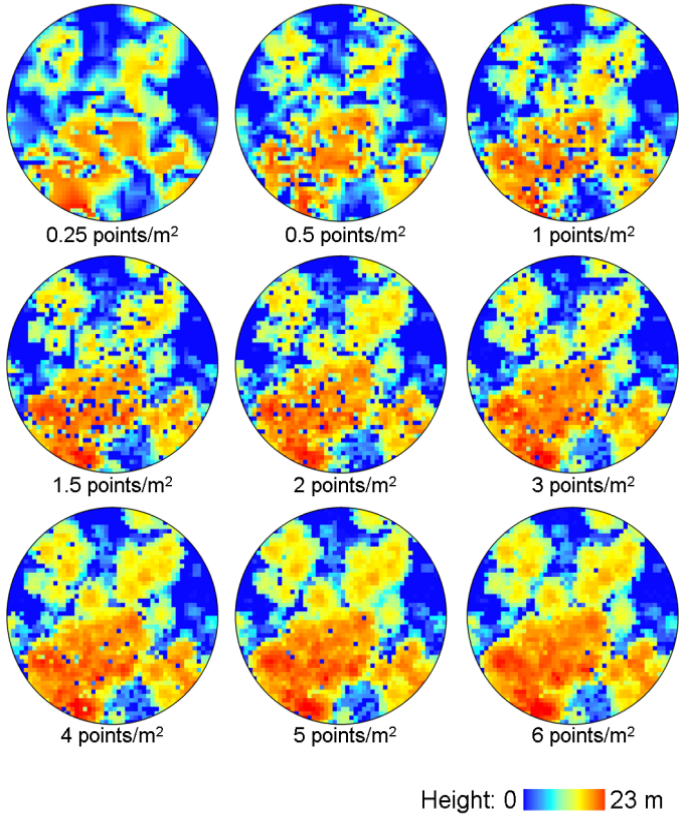
Figure 3. Canopy height models of a sample plot (radius = 25 m) obtained by a progressive variation of the simulated LiDAR density. The grid size of these models is always 1